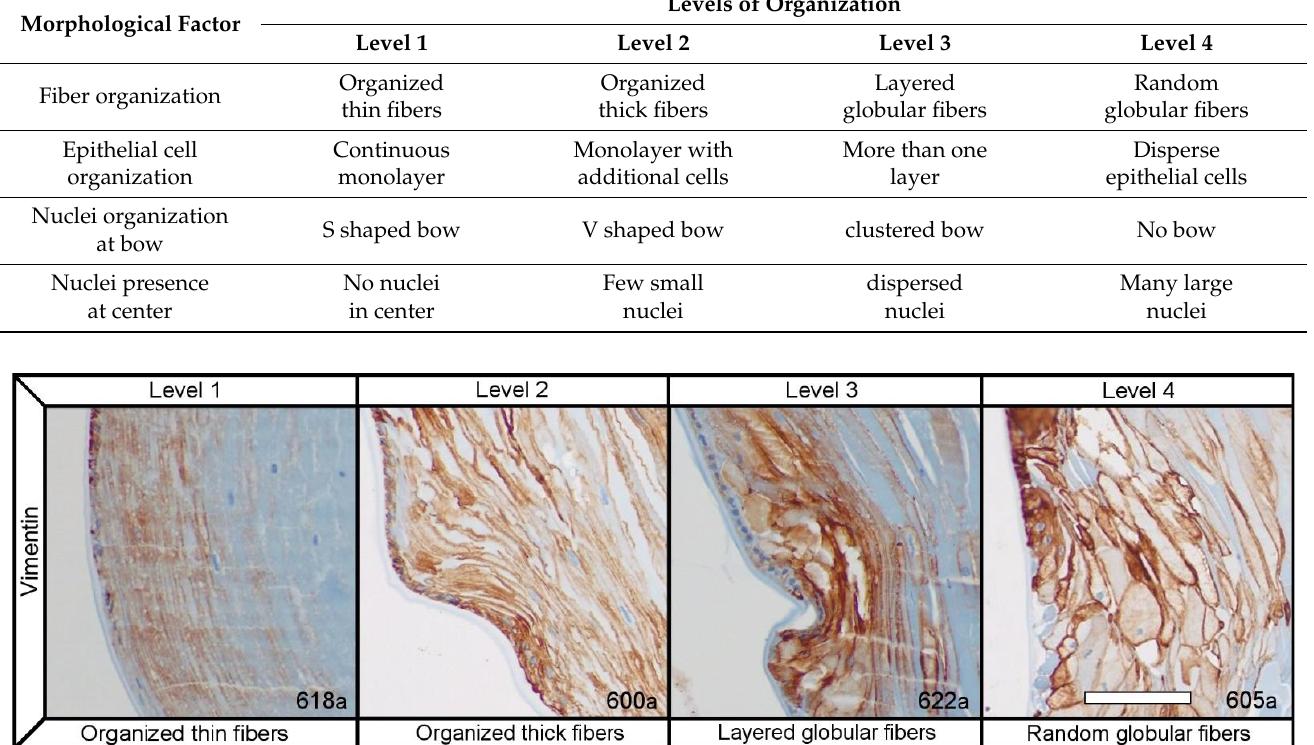
Figure 2. Histological sections of samples immunostained with vimentin, organized based on the level of fiber organization, based on the 4 levels explained in Table 2. Scale bar = 100 µm .